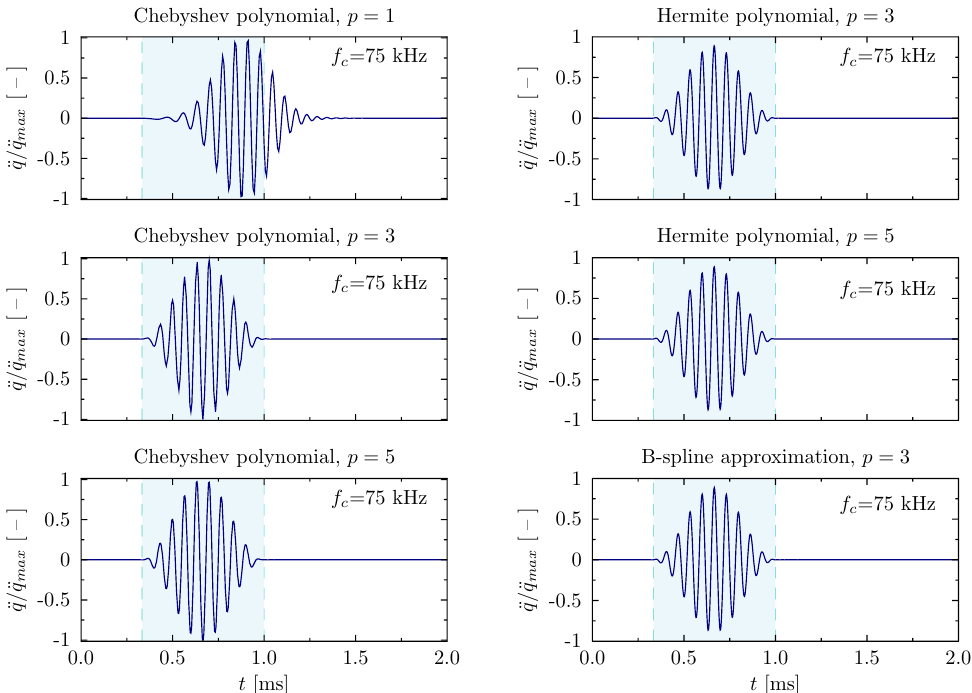
Figure 8. Wave propagation patterns of the rod calculated based on different approximation polynomials for the carrier frequency f c = 75 kHz, in the case of the rod of free ends.